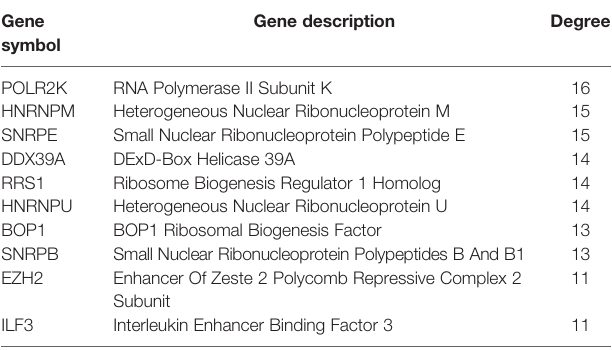
TABLE 1 | The top 10 hub genes with the highest degree of connectivity in the PPI